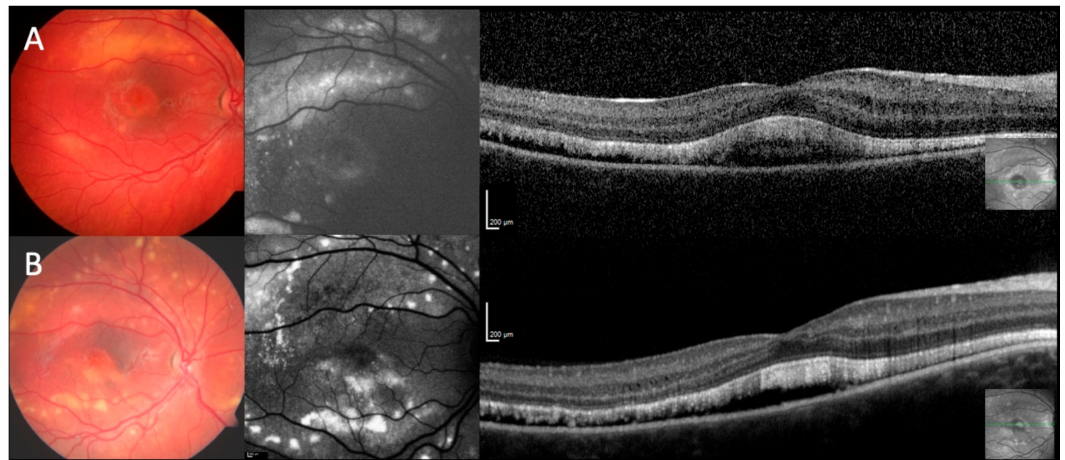
Figure 2. Disease progression. Our youngest patient (#1) ( A ) at the age of 3 ( B ) and 8 years. Fundus photograph at initial visit ( A , left column) shows multiple yellow subretinal deposits at the posterior pole with accentuation around the vessel arcades. These lesions increased in number and area over time ( B , left column). Initially, FAF ( A , middle column) depicts corresponding areas of increased autofluorescence. In some of these areas, FAF intensity increased over time, whereas in other areas FAF intensity decreased with RPE loss ( B , middle). Optical coherence tomography (OCT; A , right column) reveals a marked amount of subretinal fluid and highly reflective material which persist over time ( B , right